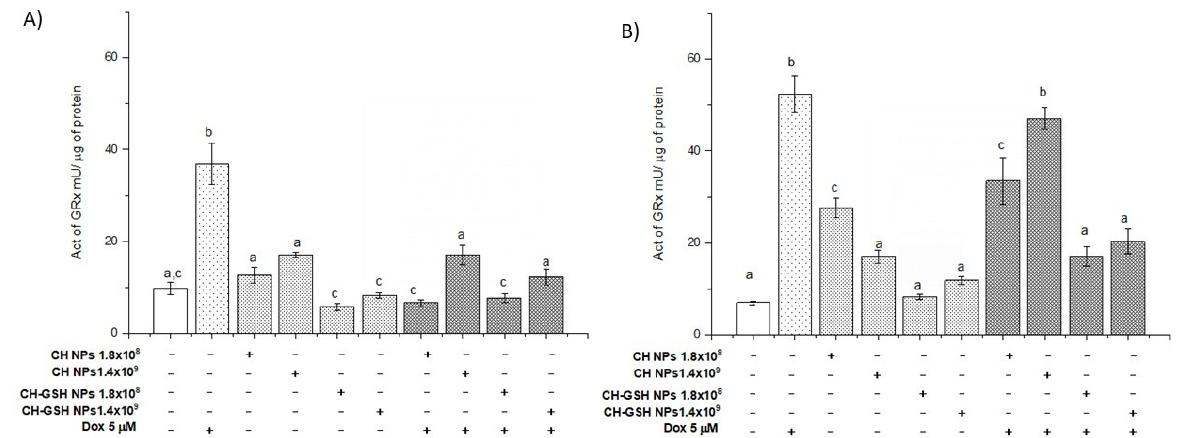
Figure 9. The activity of GRx. The cells were exposed to Dox for 12 h and then 2 h with CH-GSH NPs or CH-NPs. ( A ) MCF-7 and ( B ) MDA MB-231 cells. Bars with equal letters indicate no significant differences between the means (Tukey’s test, p < 0.05).